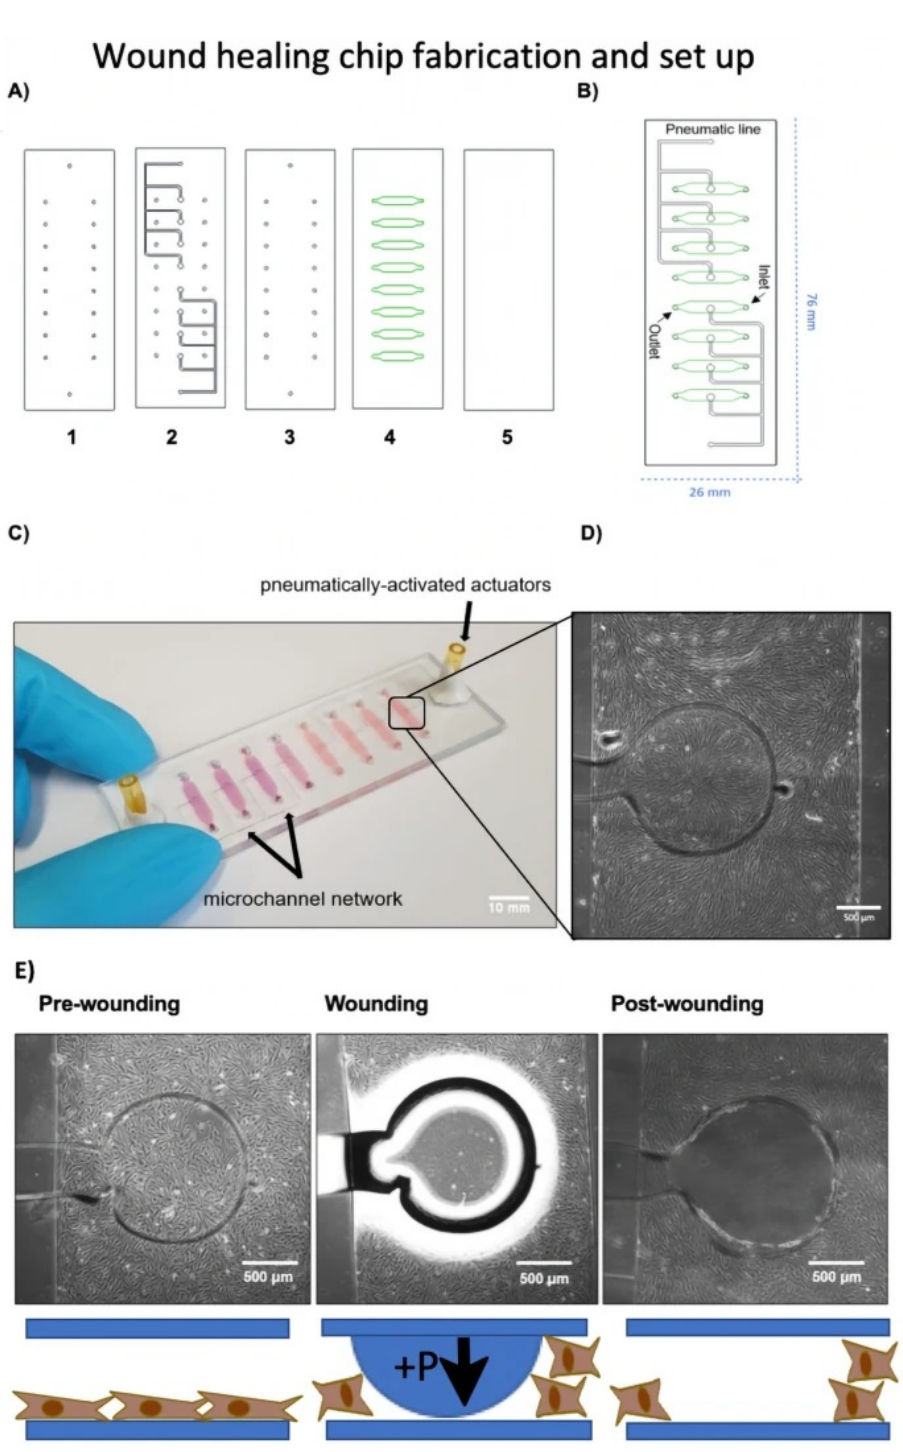
Figure 5. Schematic of microfluidic devices based in vitro wound healing assay. ( A ) Structure of 5 different PDMS layers for fabrication of chip for wound healing assay, ( B ) 2D structure of microflu- idic device showing chambers with inlets and outlets, ( C ) Microdevice image showing eight channels filled with pink dye, ( D ) magnified single channel showing defined circular wound actuators located at the center, ( E ) on chip depletion procedure showing the cell monolayer, wounding state via pres- sure application and post wounding stage indicating cell migration. Reproduced from Ref. [265] with permission from Nature Publishing Group. This work is licensed under a Creative Commons Attribution 4.0 (CC BY) International